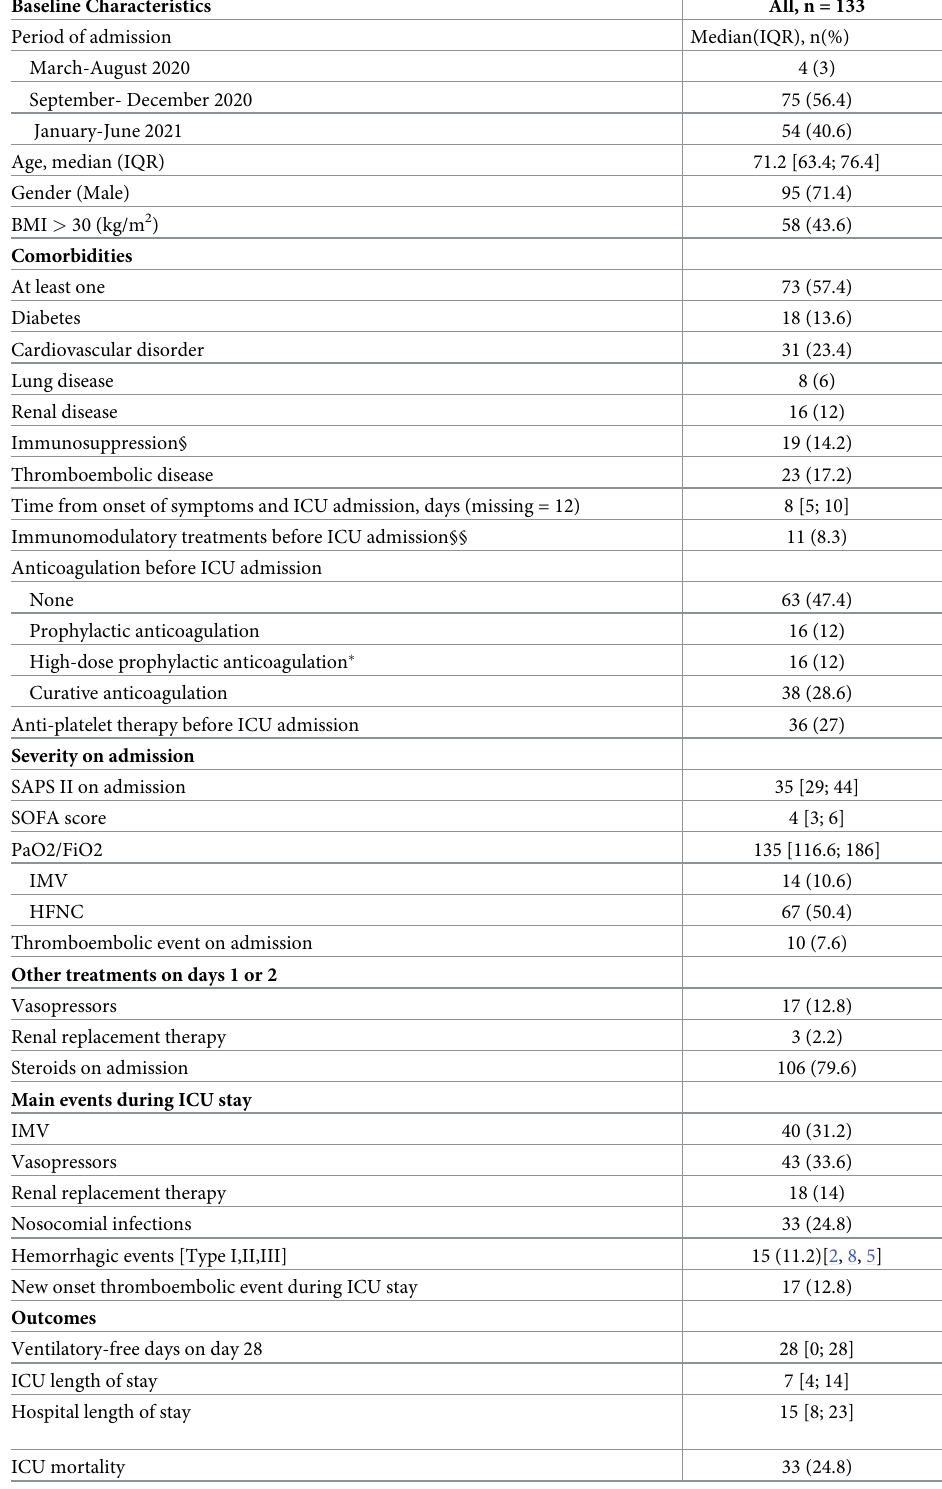
Table 1. Characteristics of patients on admission and during ICU